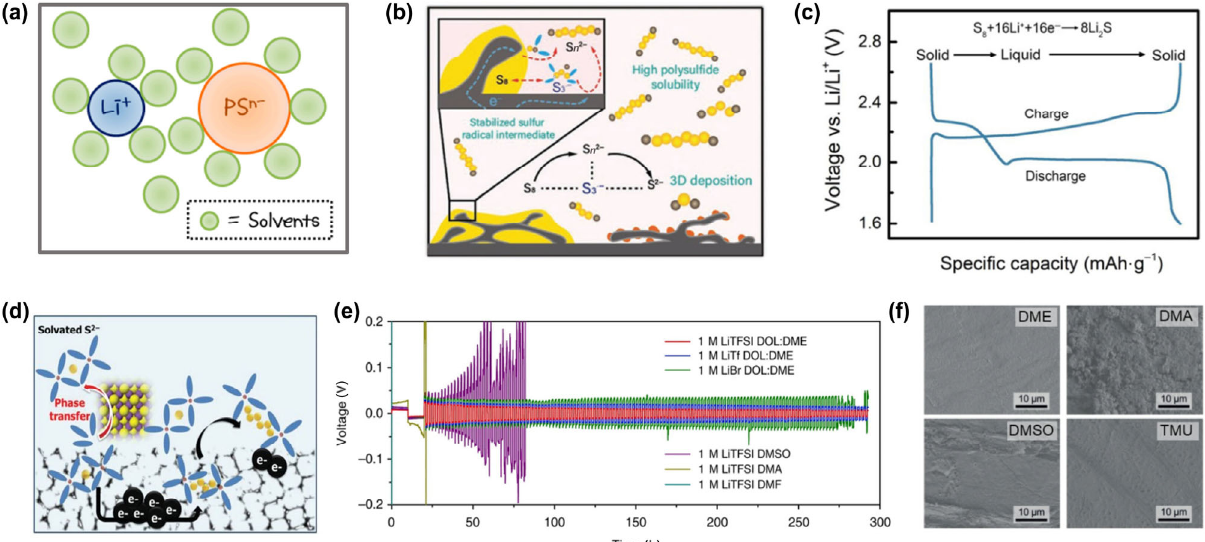
Figure 2 (a) Schematic illustration of the solvation structure, (b) sulfur electrochemical reaction mechanism, (c) charge/discharge voltage profiles, and (d) phase transfer in HSEs. Reproduced with permissions from Ref. [68], © MDPI (Basel, Switzerland) 2020; Ref. [56], © Wiley-VCH GmbH 2020; Ref. [23], © Wiley-VCH Verlag GmbH & Co. KGaA, Weinheim 2019; Ref. [59], © WILEY-VCH Verlag GmbH & Co. KGaA, Weinheim 2015. (e)